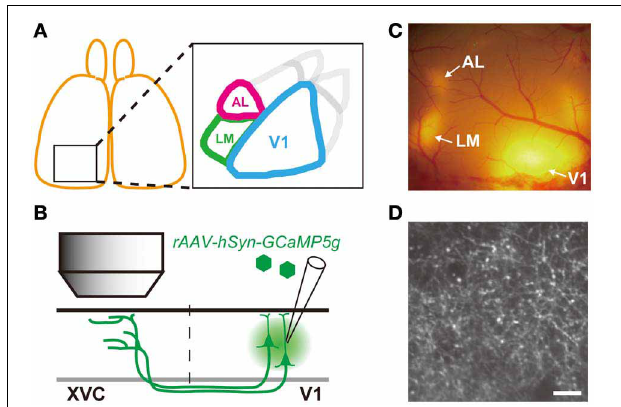
FIGURE 1 | Experimental Strategy. (A) Schematic drawing of visual area map in the mouse visual cortex. AL and LM are the two extrastriate visual areas targeted in this study. (B) Schematic drawing of experimental approach. AAV containing GCaMP5g was injected into V1. Axon terminals of V1 neurons projecting to the extrastriate visual cortex (XVC) were imaged by in vivo two photon microscopy. (C) Epifluorescence TurboRFP signal observed in vivo through the cranial window. Patches of red fluorescence are observed in V1 (injected area) as well as in XVC as smaller patches of fluorescence. (D) Representative image of axon terminals expressing GCaMP5g observed in vivo by two photon microscopy in area LM indicated in (C) . Individual axonal boutons can be clearly resolved as bright varicosities. Scale bar, 10 µ